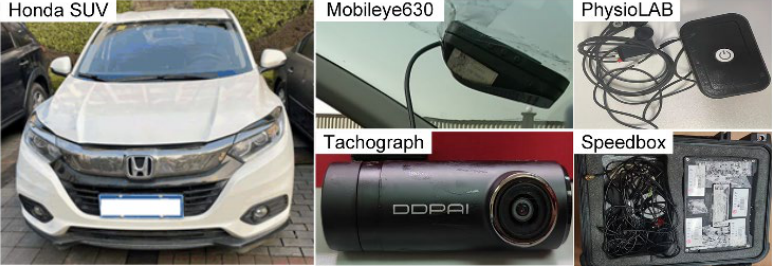
Figure 1. Experimental apparatus.